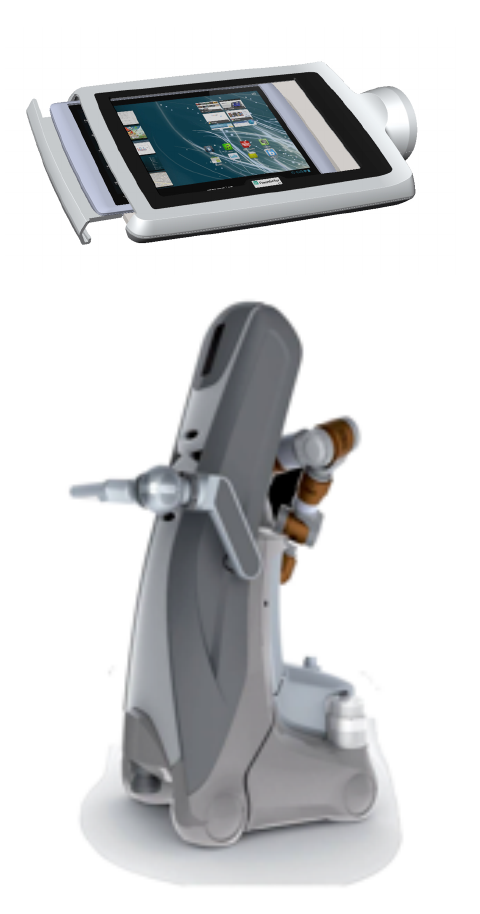
Figure 13. Design Drawings of the new tray kinematics with 3 degrees of free- dom that allows height adjustment of the tray and switching be- tween tablet pc and object placement